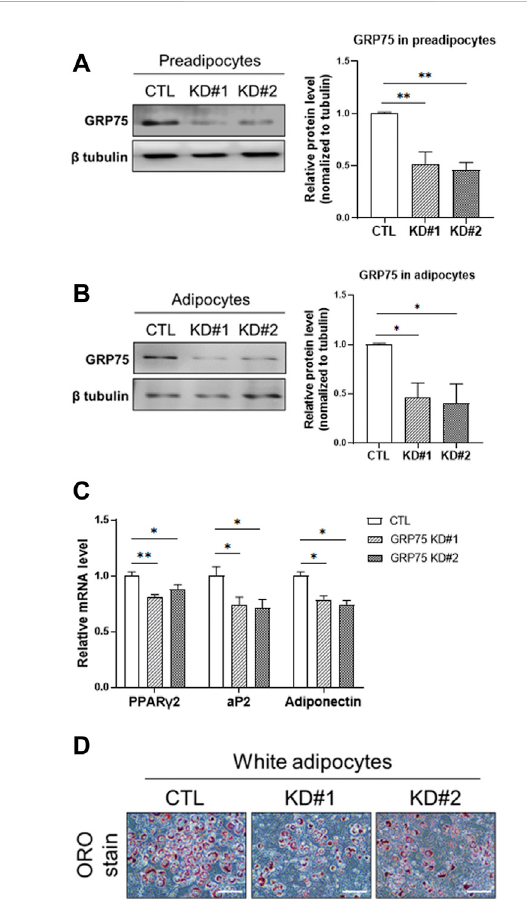
FIGURE 3 Impairment of adipogenic differentiation of 3T3-L1 preadipocytes with GRP75 knockdown. (A) The protein levels of GRP75 were determined in 3T3-L1 preadipocytes after delivering shRNA with scramble sequence (CTL) or two different sequences targeting to GRP75 (KD#1 and KD#2). The quanti fi cationofproteinbandswasshownintheleftpanel.N=3in each group. (B,C) The 3T3-L1 preadipocytes with CTL KD, GRP75 KD#1 and GRP75 KD#2 were induced to undergo adipogenic differentiation for 7 days. Protein levels of GRP75 (B) and mRNA levels of PPAR γ 2, aP2 and adiponectin (C) were determined by Western blot (N = 3 in each group) and RT-PCR (N = 6 in each group), respectively. (D) The 3T3-L1 preadipocytes with CTL KD, GRP75 KD#1 and GRP75 KD#2 were induced to undergo adipogenic differentiation for 7 days and were then stained by Oil red O. Scale bar = 500 μ m. Data are presented as means ± SEM; * p < 0.05; ** p < 0.01.